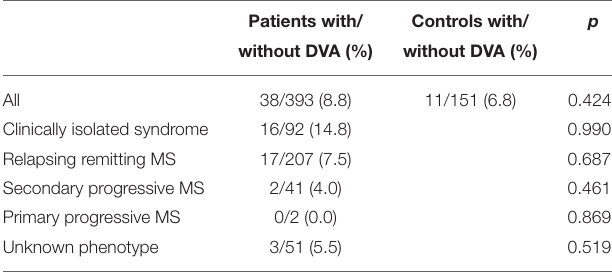
TABLE 1 | Demographic and clinical data of patients and controls.